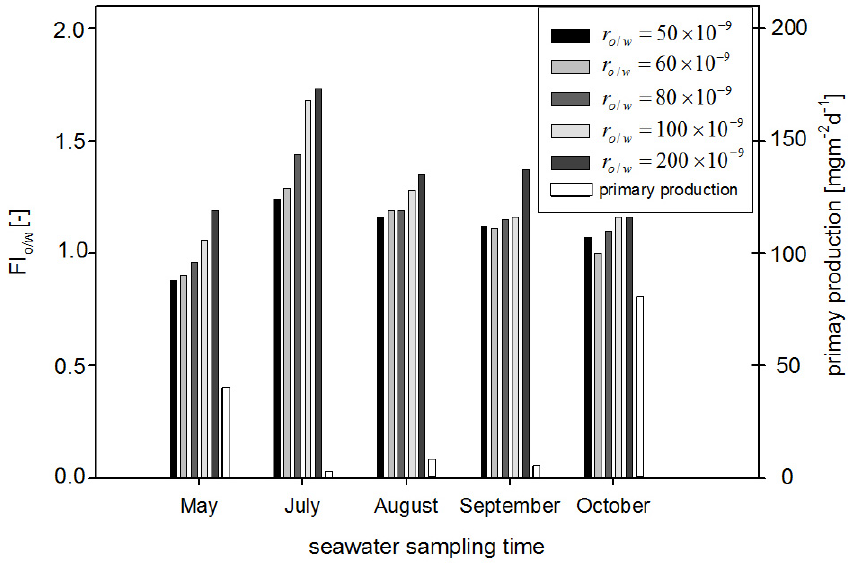
Figure 10. Fluorescence index of seawater polluted with oil in comparison with primary production.